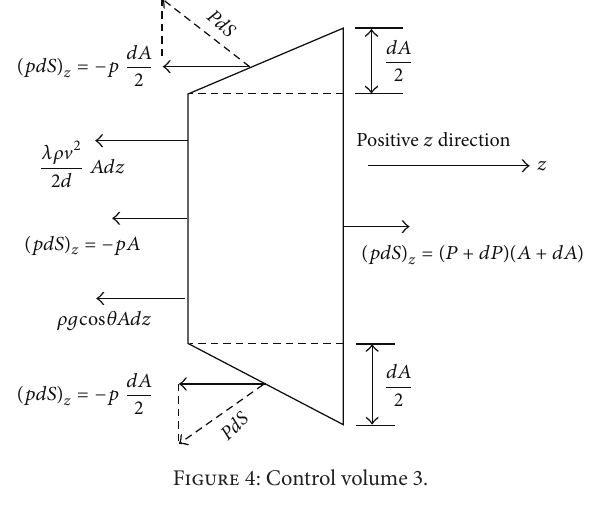
Figure 4: Control volume